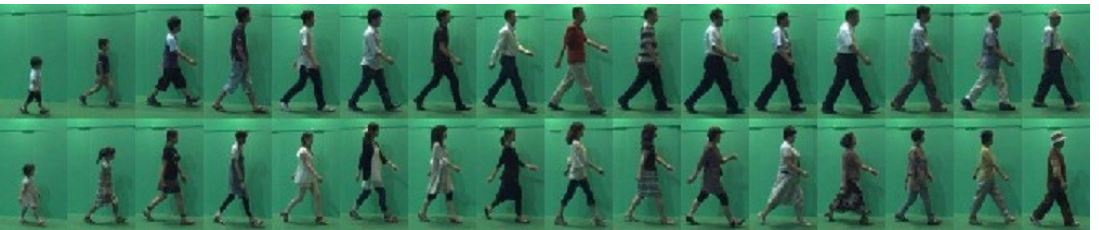
Figure 6: Gait examples of subjects in OU-ISIR-LP